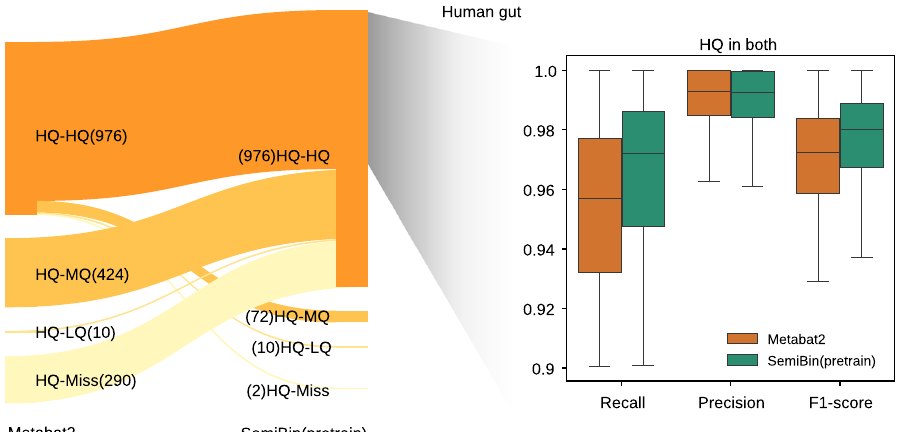
Fig. 4 SemiBin(pretrain) reconstructed more and better high-quality bins compared to Metabat2 in human gut dataset. We identi fi ed the overlap between the bins in the human gut from Metabat2 and SemiBin(pretrain) using Mash (see Methods). Within bins that are present at high-quality in the output of both binners, SemiBin(pretrain) achieved higher completeness (recall) ( P = 2.236 × 10 − 67 ( n = 82)) without a statistically signi fi cant increase in contamination (1 − precision) ( P = 0.167 ( n = 82)). The overall F1-score is signi fi cantly better ( P = 9.287 × 10 − 67 ( n = 82); all P values were computed using the Wilcoxon signed-rank test, two-sided null hypothesis). Similar results were obtained in the dog gut and ocean datasets (see Supplementary Fig. 13). For the box plots, the centerline is the median of all values, the lower and upper bounds of the box correspond to 25th and 75th percentiles and the lower and upper of the whiskers are the minimum and maximum values. Source data are provided as a Source Data fi le.